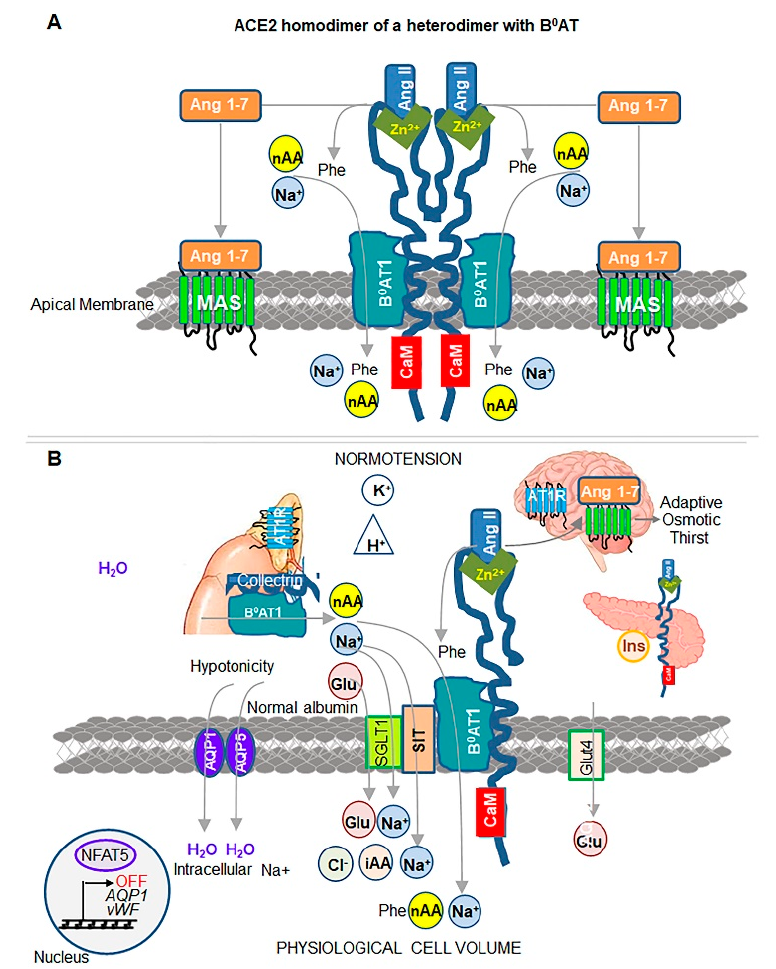
Figure 5. Cumulative function of ACE2 complex with Na + -dependent transporters. ( A ) Schematic presentation of enzymatically active ACE2 homodimer undergoing heterodimerization with sodium-dependent transporter B 0 AT1 (SLCA19) to stabilize this complex, based on cryo-electron microscopy structure [12]. ACE2 homodimerization is mediated by polar interactions and disulfide bridge formation. ACE2 is stabilized by CaM to avoid shedding. B 0 AT1 interacts with extended collectrin- like domain of ACE2. B 0 AT1 transports neutral amino acids (nAA including Phe cleaved from Ang II) across the apical membranes of small intestine, lungs and other organs, excluding the kidneys. One Na + is co-transported per amino acid. ( B ) ACE2 complex with Na + -dependent transporters contribute to regulation of physiological cell volume and normotension in blood. For clarity, here and below, the ACE2 dimer has been shown as a monomer. ACE2/B 0 AT1 complex also includes other Na + -dependent transporters, such as SIT for imino acids (iAA) and Cl − and SGLT1 for glucose (Glu). In addition to their metabolic value, these nAA, iAA, and glucose serve as organic osmolytes, which maintain osmolality together with Na + ions. Water influx is mediated by aquaporins (AQP1 and AQP5) in response to hypotonicity. Insulin secretion is controlled by pancreatic activity of ACE2/B 0 AT1 complex that increase glucose intake by glucose transporter 4 (GLUT4). The balanced levels of organic osmolytes, ions, and water sustain physiologic cell volume, thereby NFAT5 and its target genes vWF and AQP1 remain inactive (OFF). In the kidney, B 0 AT1 functions in a complex with collectrin, where it reabsorbs nAA and Na + from urine. Ang (1–7)/MAS signaling in the brain regulates adaptive osmotic thirst [76]. Unliganded AT1R receptor is inactive. The concentration of water, albumin, K + , and H + is in the physiologic range. Physiological cell volume is accompanied by normotension on blood when ACE2 complex is intact. Collectrin is an obligatory partner of B 0 AT1 only in the kidney [77], where deficiency in collectrin manifests with severe neutral hyperaminoaciduria [77]. Loss-of-function mutations of B 0 AT1 [78] can cause one or multiple symptoms of the autosomal recessive Hartnup disorder (OMIM 234500) [78,79], particularly aminoaciduria, stunted growth, and development [75]. In this disease, the deficient transport of tryptophan for the synthesis of niacin can manifest as dermatitis and/or cerebellar ataxia